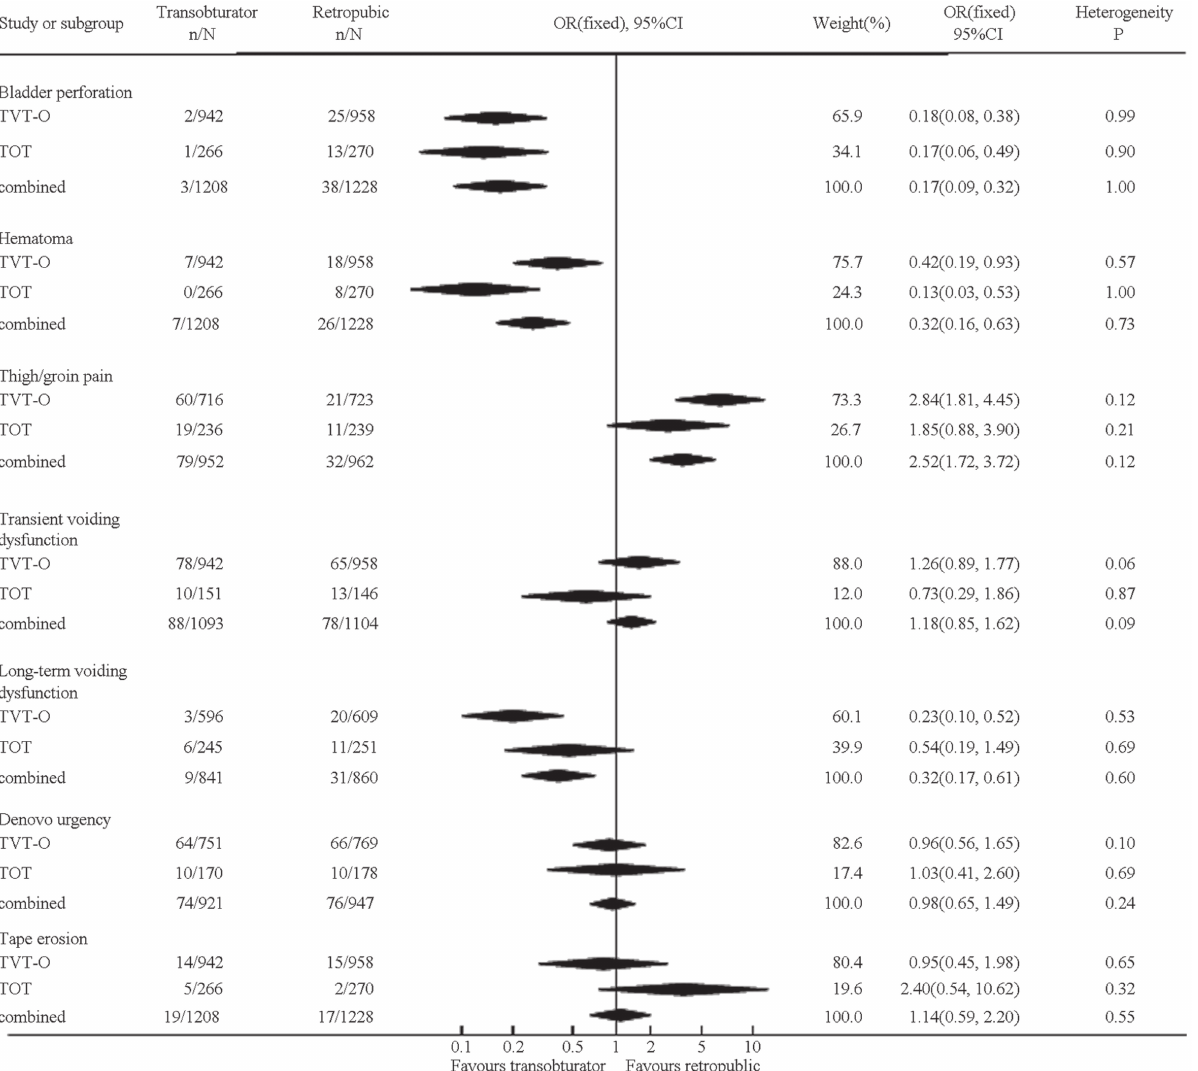
Figure 4 - Complications of the two procedures (TVTO and TOT) in comparison with